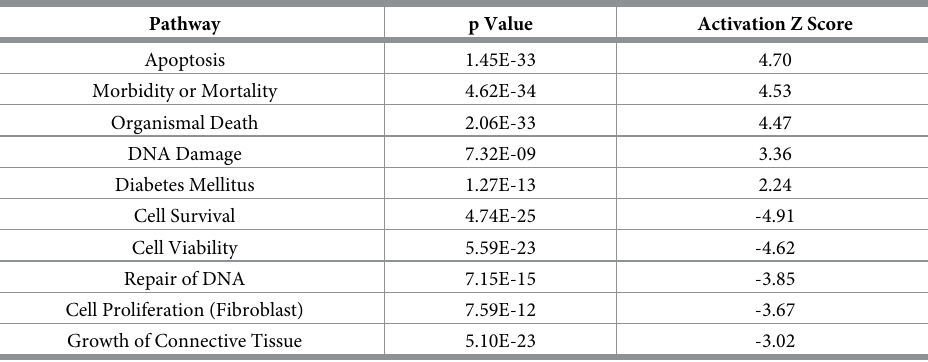
Table 3. Select IPA pathway